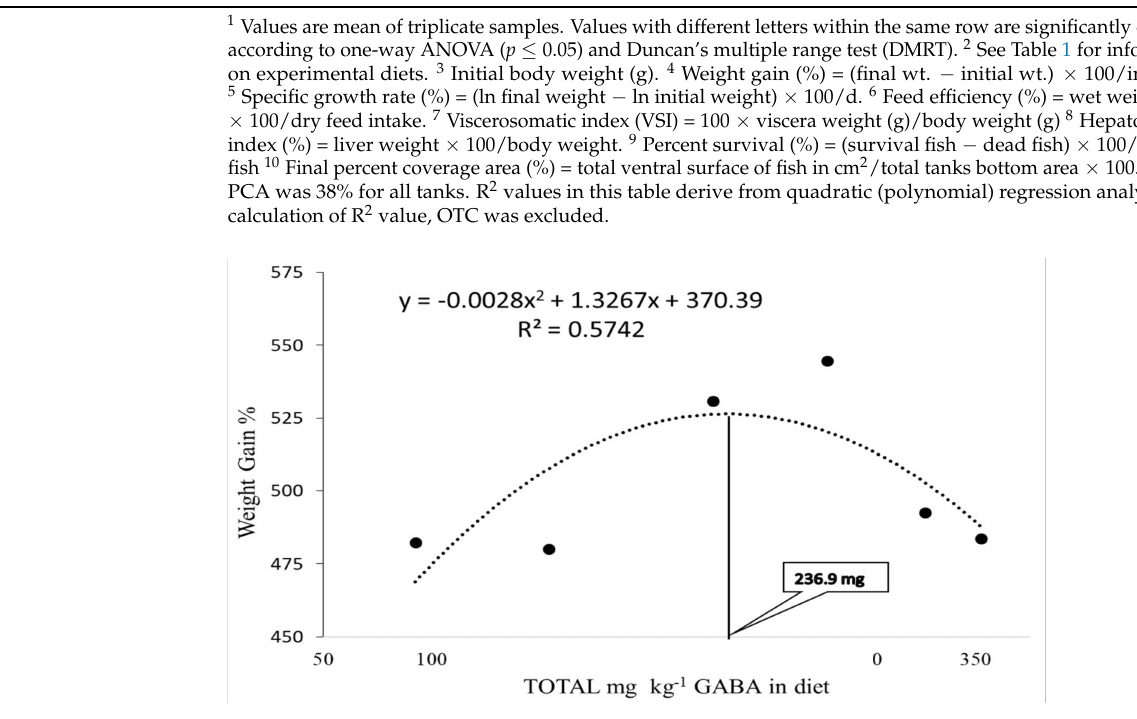
Figure 1. Optimal level of dietary GABA in mg/kg according to WG by polynomial analysis in Juvenile olive flounder fed the experimental diets (OTC was excluded in this analysis). GABA concentration on the X axis is according to actual GABA levels of diets: CON, GAB 50 , GAB 100 , GAB 150 , GAB 200 , and GAB 250 as determined by HPLC analysis. See Table 1 for more information about formulation and GABA content.